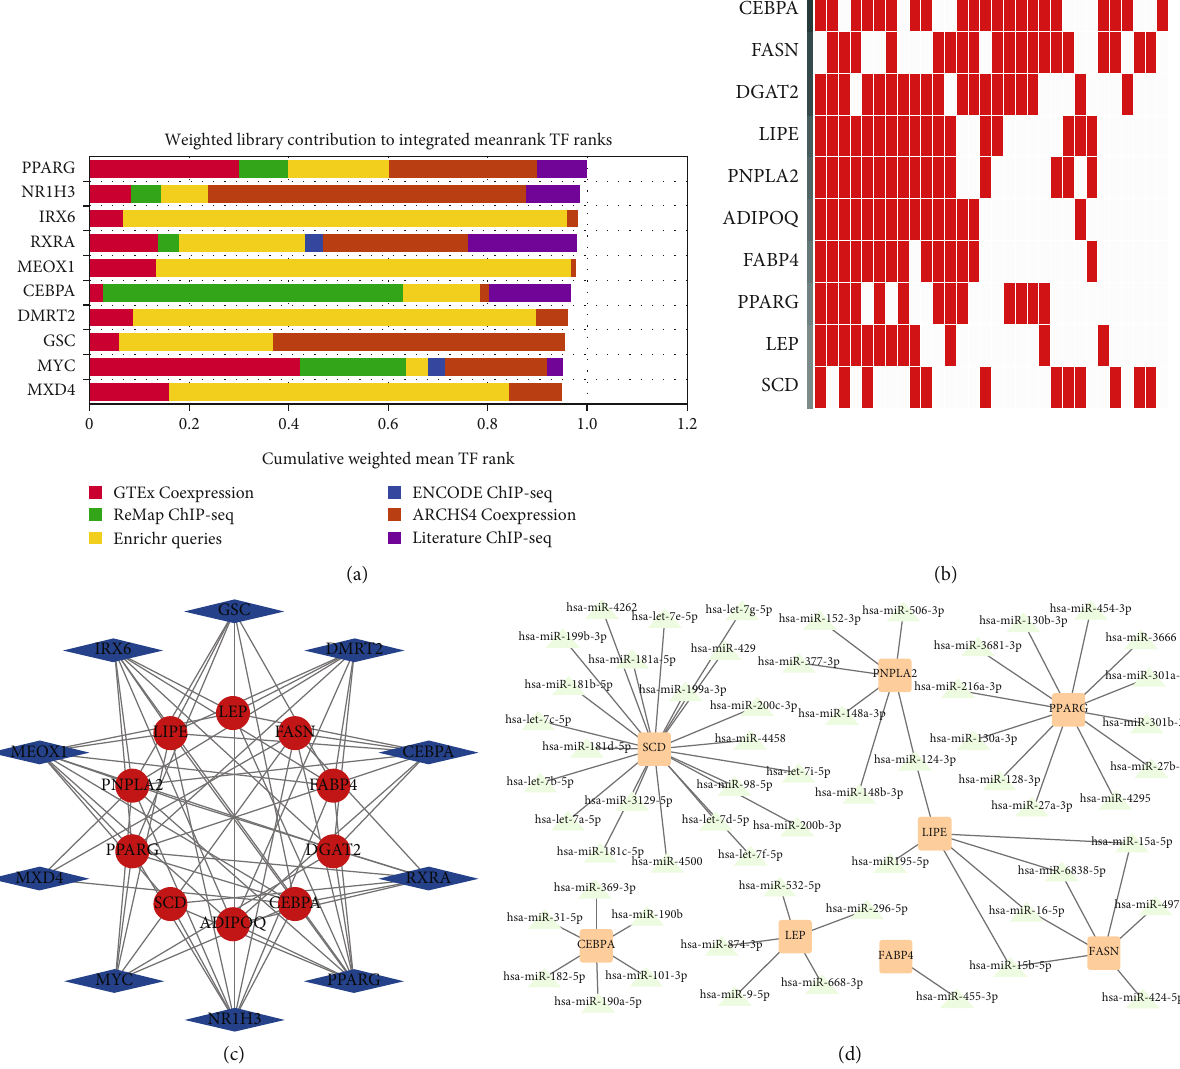
Figure 6: Predicted TFs of hub genes. (a) Top 10 predicted TFs for hub genes, including PPARG, NR1H3, IRX6, RXRA, MEOX1, CEBPA, DMRT2, GSC, MYC, and MXD4. (b) The heat map represents TF predicted by di ff erent databases (ENCODE, ReMap, GTEx, Enrichr, and ARCHS4). (c) PPI network between hub genes and the top ten predicted TF. (d) Interaction between hub genes and predicted